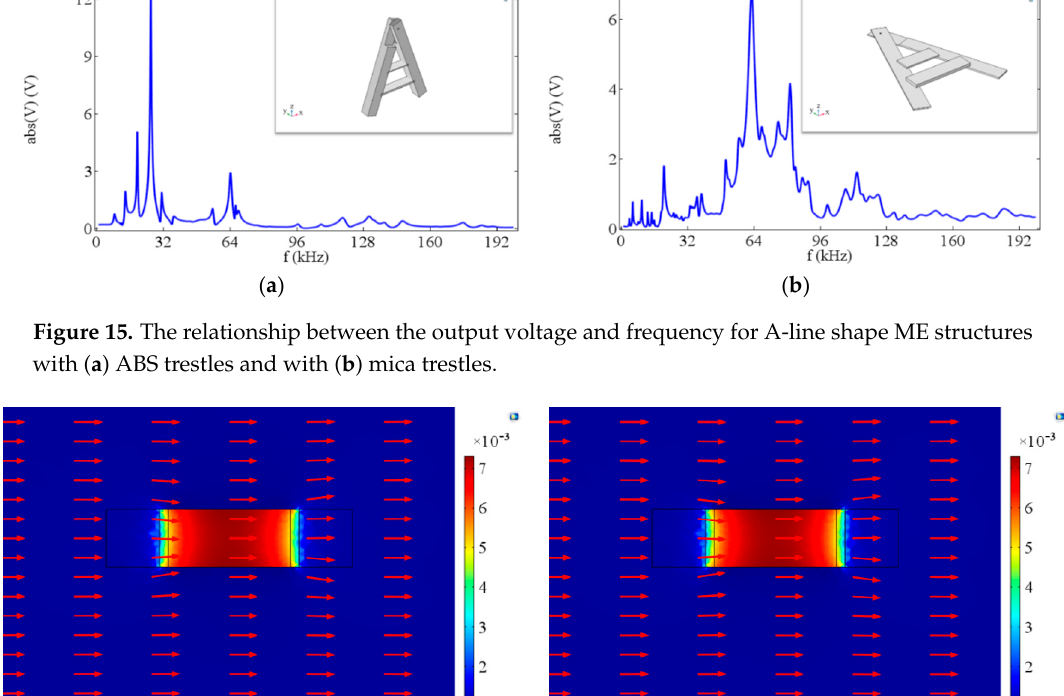
Figure 15. The relationship between the output voltage and frequency for A-line shape ME structures with ( a ) ABS trestles and with ( b ) mica trestles.